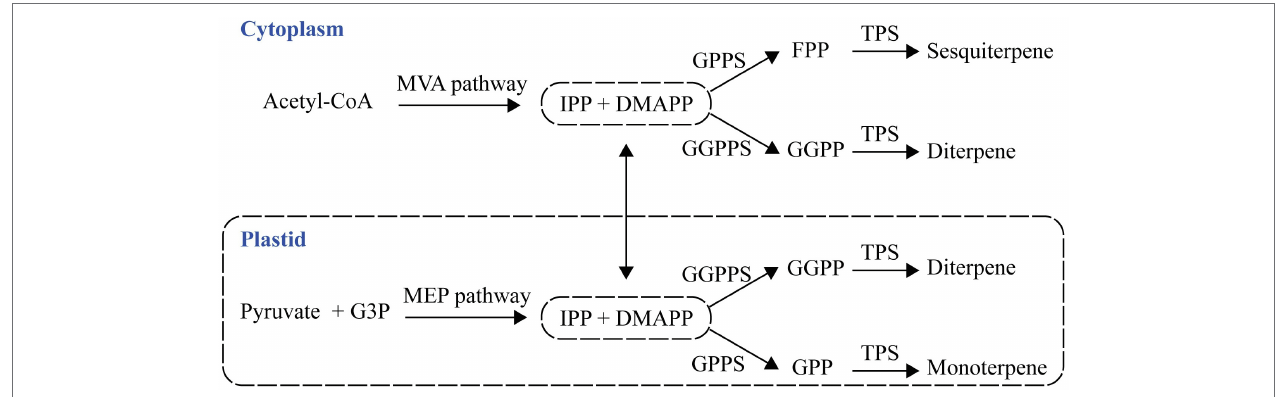
FIGURE 1 | The pathway of plant terpenes biosynthesis. Terpenes are synthesized from two precursors generated by the cytosolic mevalonate acid (MVA) and plastid methylerythritol phosphate (MEP) pathways. G3P, glyceraldehyde 3-phosphate; IPP, isopentenyl diphosphate; DMAPP, dimethylallyl diphosphate; GPP, geranyl diphosphate; GPPS, GPP synthase; FPP, farnesyl diphosphate; FPPS, FPP synthase; GGPP, geranylgeranyl diphosphate; GGPPS, GGPP synthase; and TPS, terpene